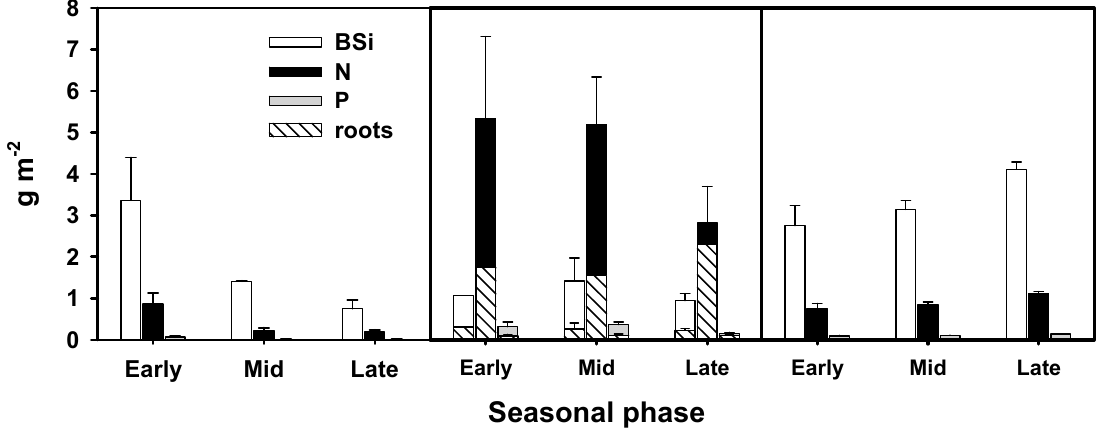
Figure 2. Biogenic silica (BSi), nitrogen (N), and phosphorus (P) stocks in the primary producer biomass in the three sampling periods. Error bars represent standard error (n = 6). Legend: RS = rocky shores; VS = vegetated sediments; BS = bare sediments. At site BS, BSi, N, and P were estimated from sedimentary